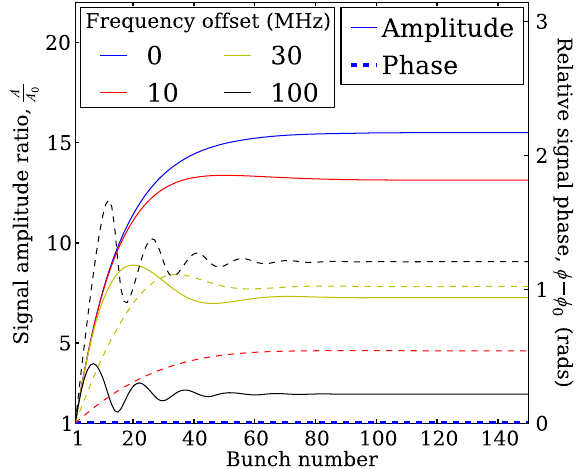
FIG. 1. Signal rise in amplitude and phase against the number of bunches as predicted by Eqs. (7) and (8).